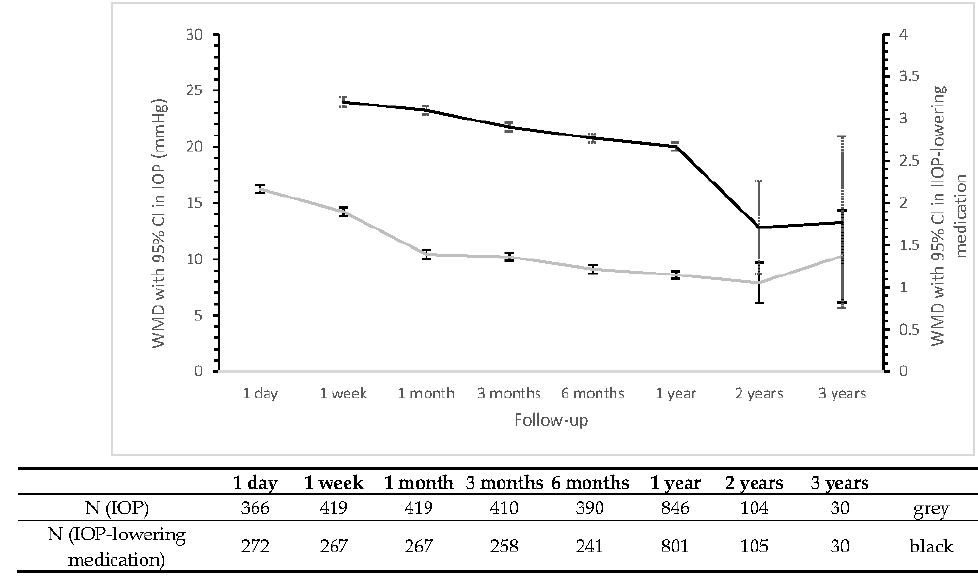
Figure 3. ( A , B ) Meta-analyses for the change in intraocular pressure (IOP; grey) and number of IOP-lowering medications (black) after PRESERFLO MicroShunt surgery. Presented as the pooled mean with standard deviation ( A ) and weighted mean difference (WMD) with corresponding 95% confidence intervals ( B ). Table below gives the number of eyes. After 3 years of follow-up, the WMD (95%, CI; I2) IOP and IOP-lowering medication was 10.27 mmHg (8.23–12.32; 91%) and 1.77 (1.26–2.28; 0%), respectively. However, as